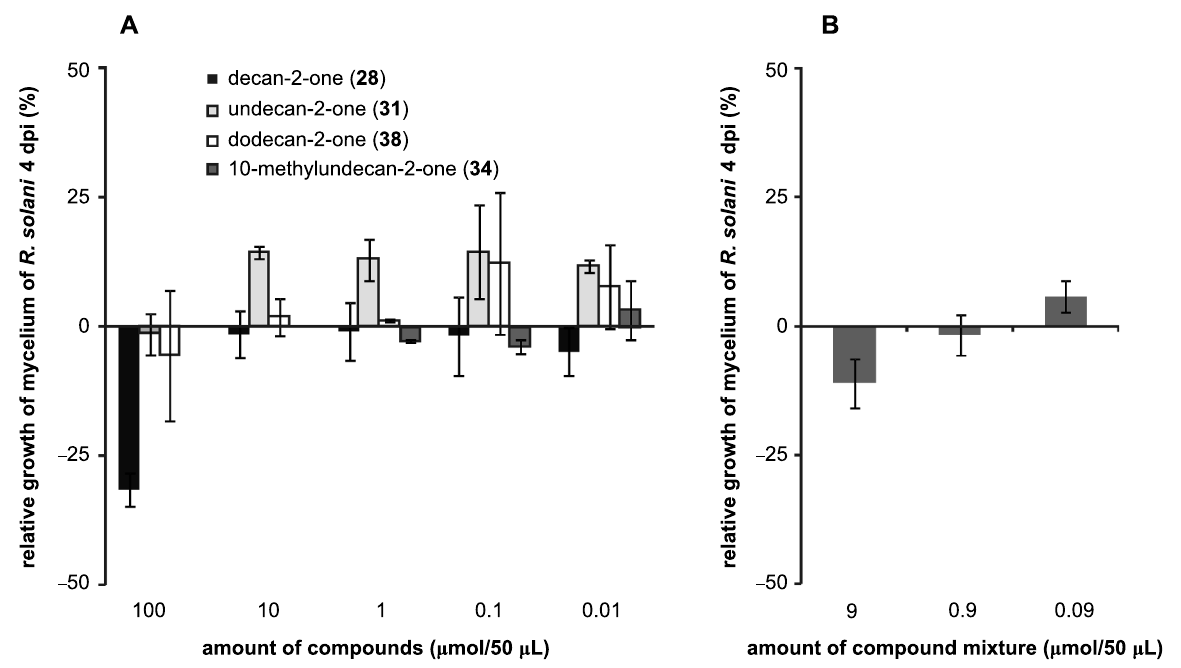
Figure 6: Testing synthetic volatiles on the growth of Rhizoctonia solani. Synthetic commercially available and chemically synthesized ketones were dissolved in pentane and applied on a filter-paper disc in aliquots of 50 μ L. The filter paper was placed in the opposite compartment to the R. solani in a bi-partite Petri dish. Defined dilutions or mixtures were applied every 24 h. At day 4 the diameter of the mycelium was measured and compared to control plates containing pentane. Positive values represent growth promotion and negative values growth inhibition of R. solani compared to the control. Data are from two experiments each replicated three times; the standard deviation is presented. (A) Decan-2-one ( 28 ) (black), undecan-2-one ( 31 ) (light grey), dodecan-2-one ( 38 ) (white), and 10-methylundecan-2-one ( 34 ) (dark grey) were individually applied in 50 μ L aliquots each day (day 0 to day 4). (B) A mixture of 28 , 31 , 38 and 34 (6.7%:5.5%:0.6%:87.2%) was applied in 50 μ L aliquots every day (day 0 to day